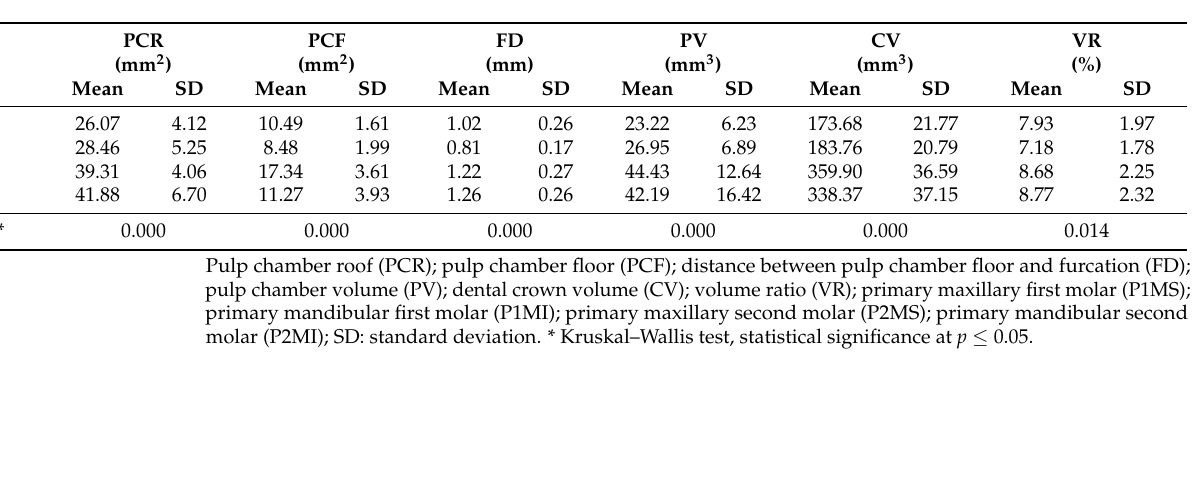
Table 1. Measurements of the pulp chamber, furcation, and coronal portion of the